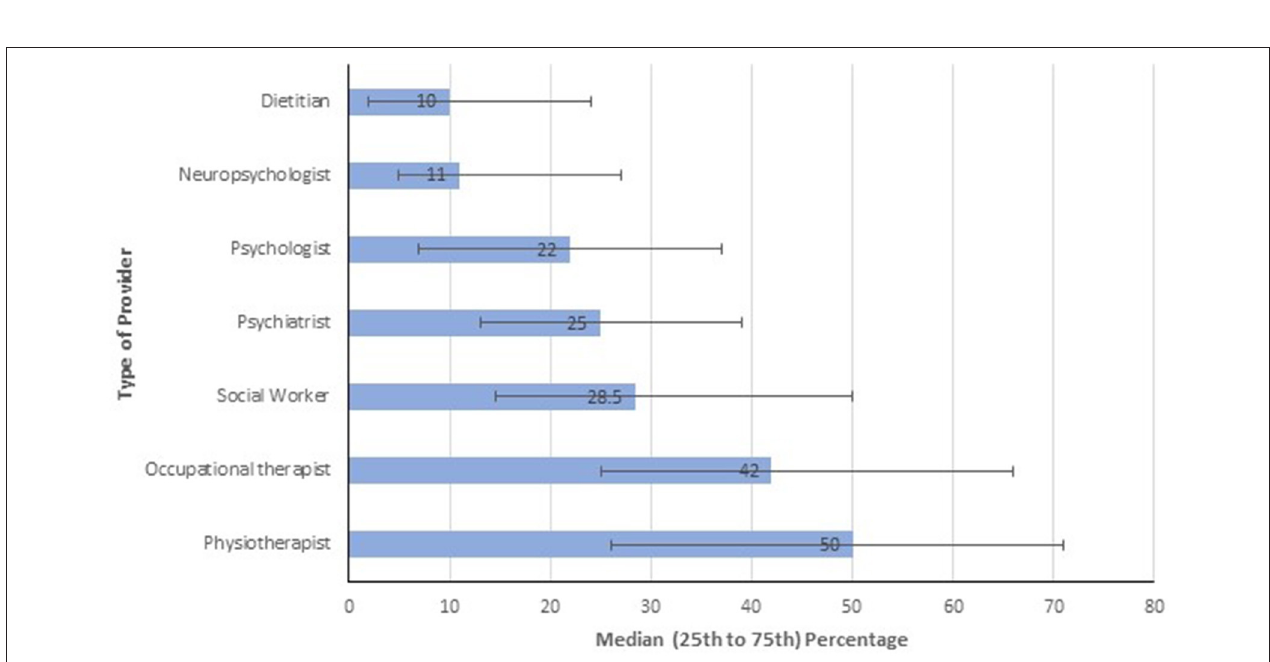
FIGURE 3 | Percentage of patients seen referred to different types of